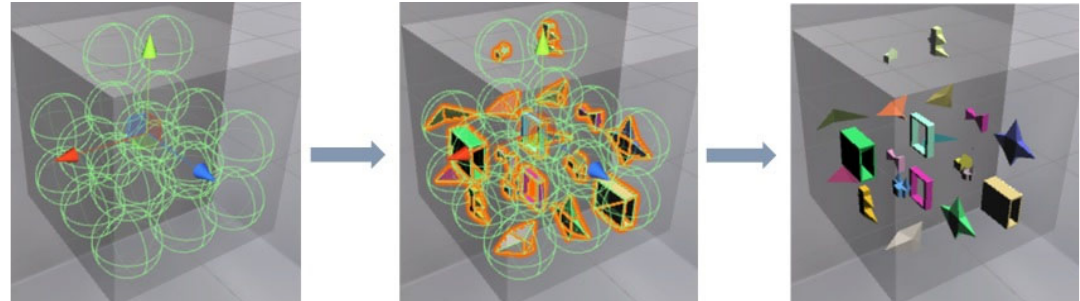
Fig. 6. Assignation of small items to the spheres and then the elimination of the